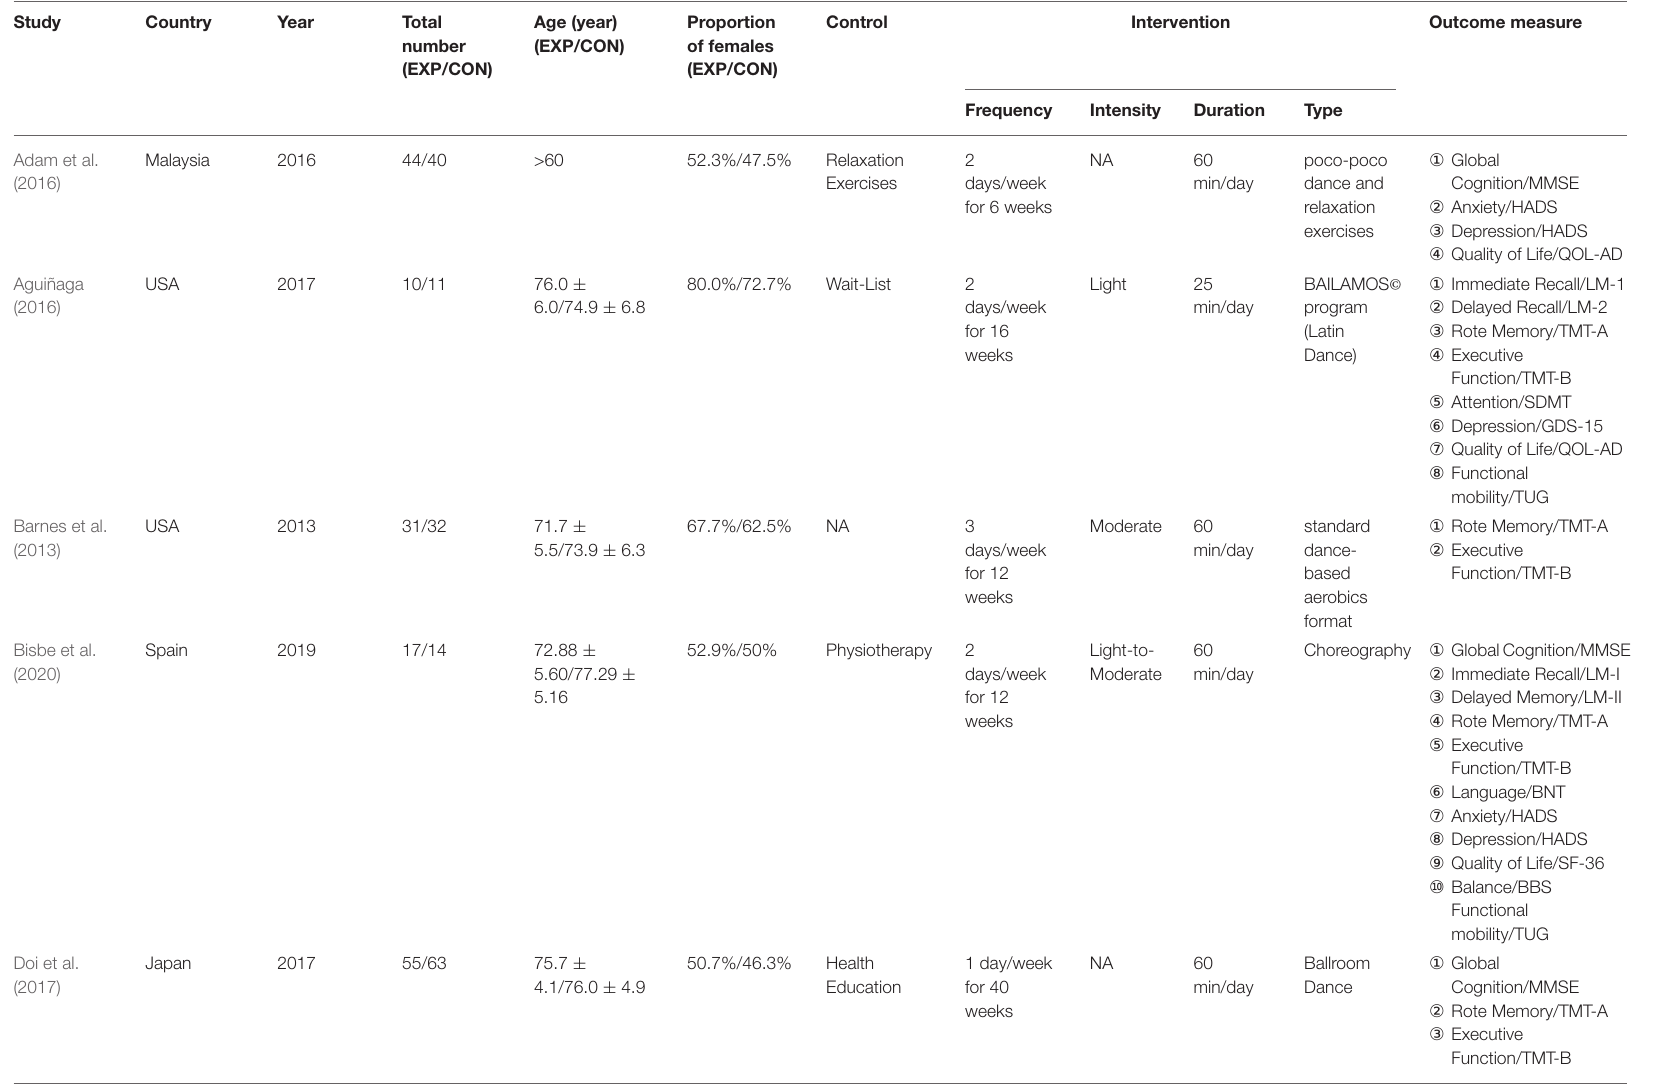
TABLE 1 | Characteristics of included